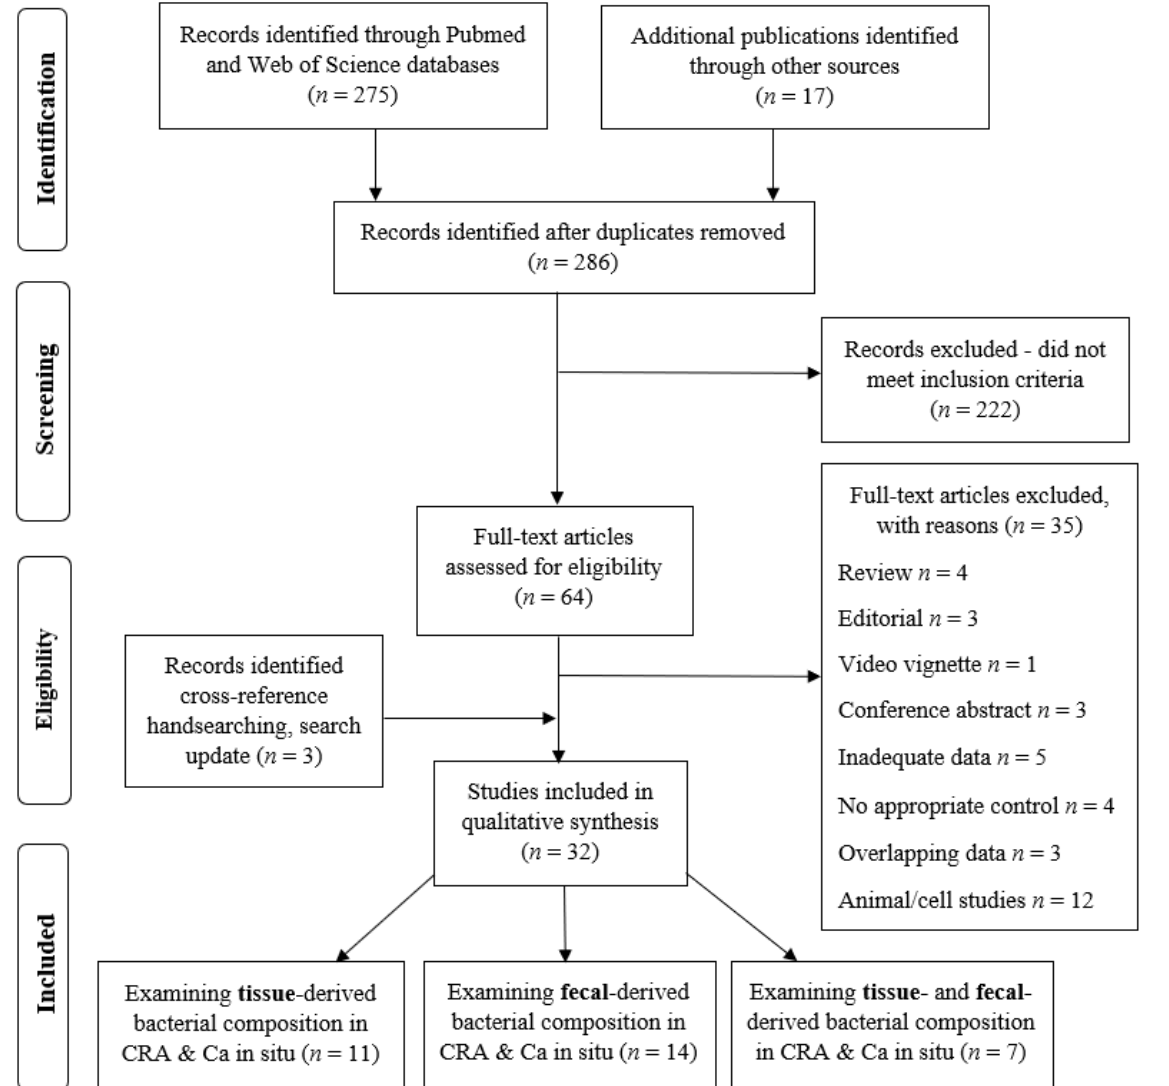
Figure 1. PRISMA flow diagram indicating the selection of studies for the systematic review.